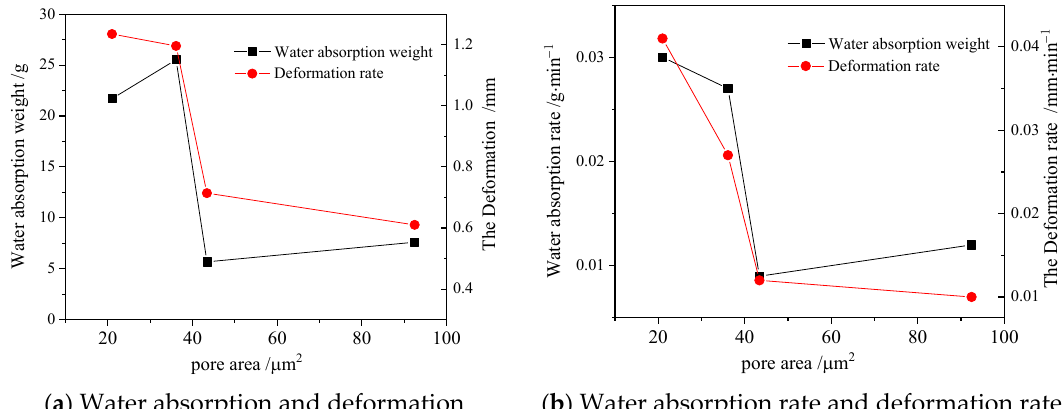
Figure 12. Relationship between pore area and deformation.